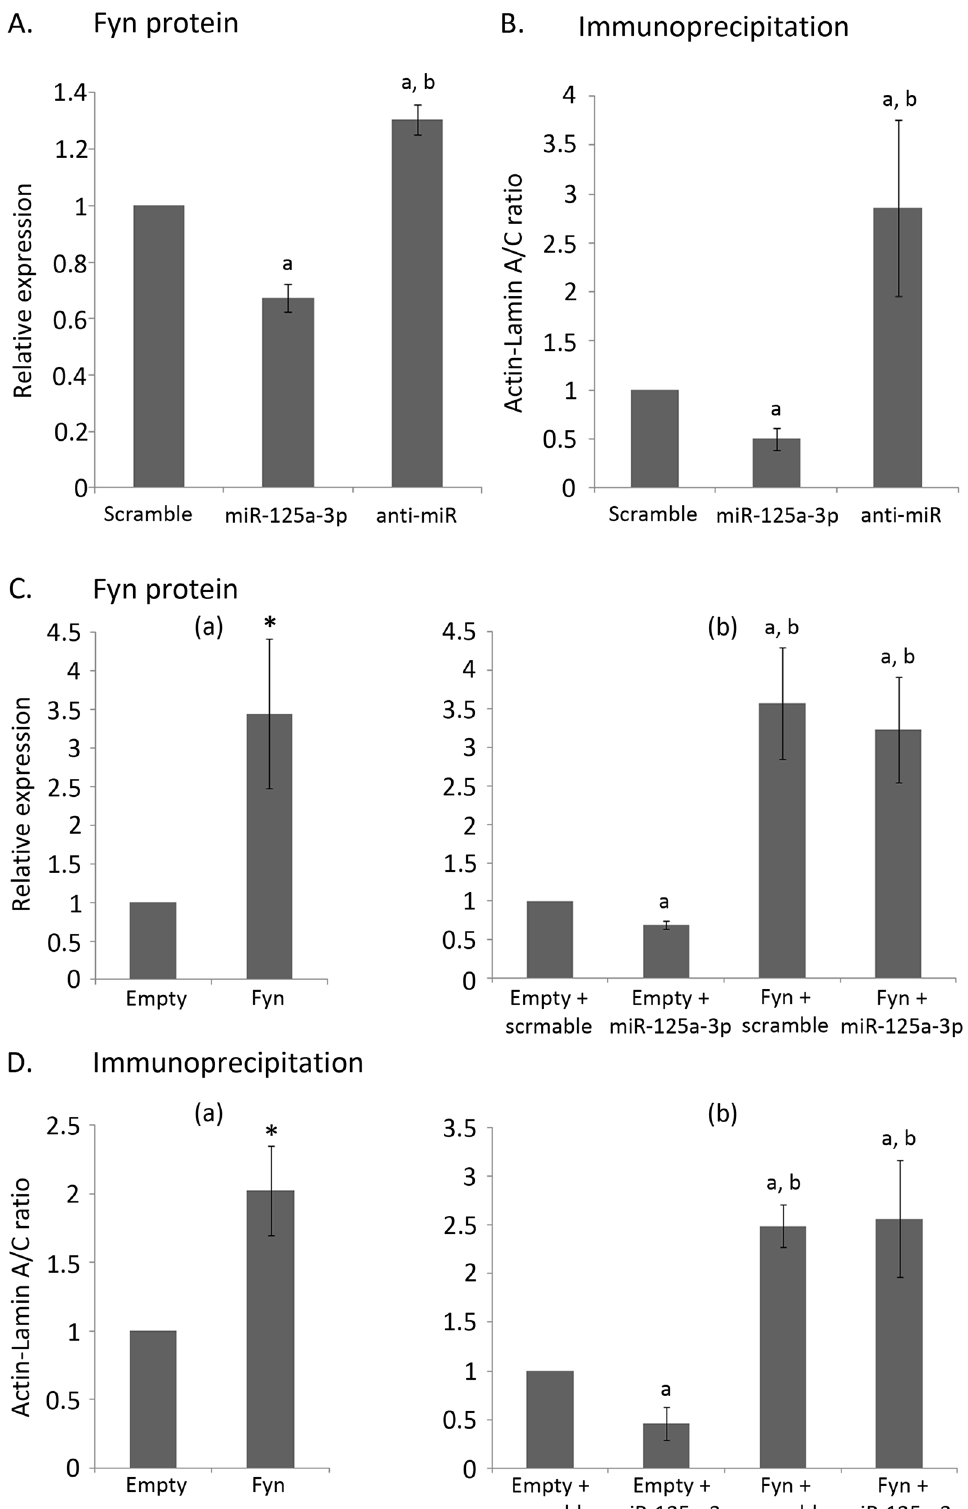
Figure 6. miR-125a-3p decreases the interaction of A-type lamins and actin in a Fyn-dependent manner. ( A , B ) HEK-293 T cells, transfected with either miR-125a-3p mimic (miR-125a-3p), anti-miR or scramble- miR (Scramble), were incubated for 24 hours, lysed and subjected to ( A ) WB analysis using anti-Fyn antibody and anti-actin as a loading control, or to ( B ) immunoprecipitation with anti-lamin A/C antibody and immunoblotted with anti-actin and anti-lamin A/C. Results are normalized to scramble. Data were analyzed by one-way ANOVA followed by Tukey post hoc test. Bars are Mean ± SEM of at least three independent experiments. a,b p < 0.05; a versus Scramble; b versus miR-125a-3p. ( C , D ) HEK-293 T cells